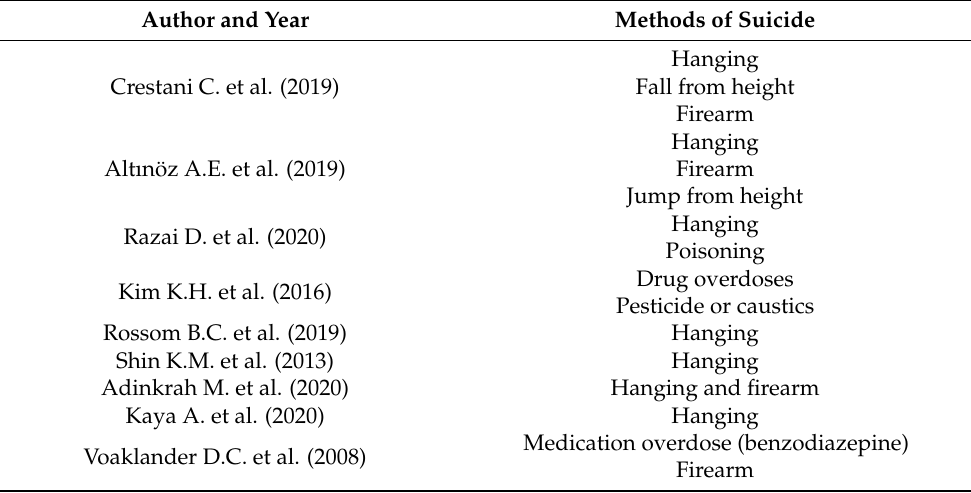
Table 3. Summary of the most common methods used in suicide in the